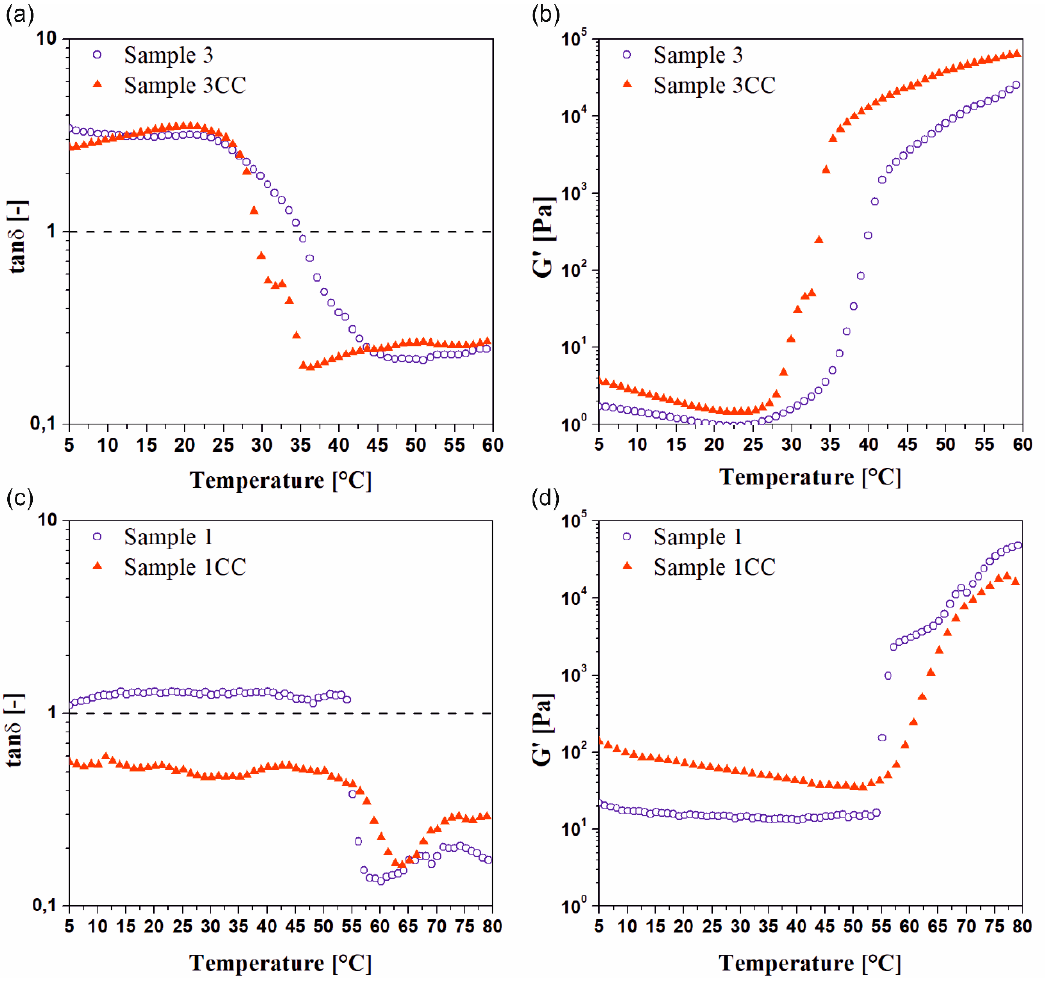
Figure 8. Experimental curves tan δ as a function of temperature for sample 3 and 3CC ( a ), and sample 1 and 1CC ( c ). Experimental curves of storage modulus G’ as a function of temperature for sample 3 and 3CC ( b ), and sample 1 and 1 CC ( d ). Table 3. The values of the storage modulus G’ and the dynamic viscosity η determined on the basis of non-isothermal measurements at critical